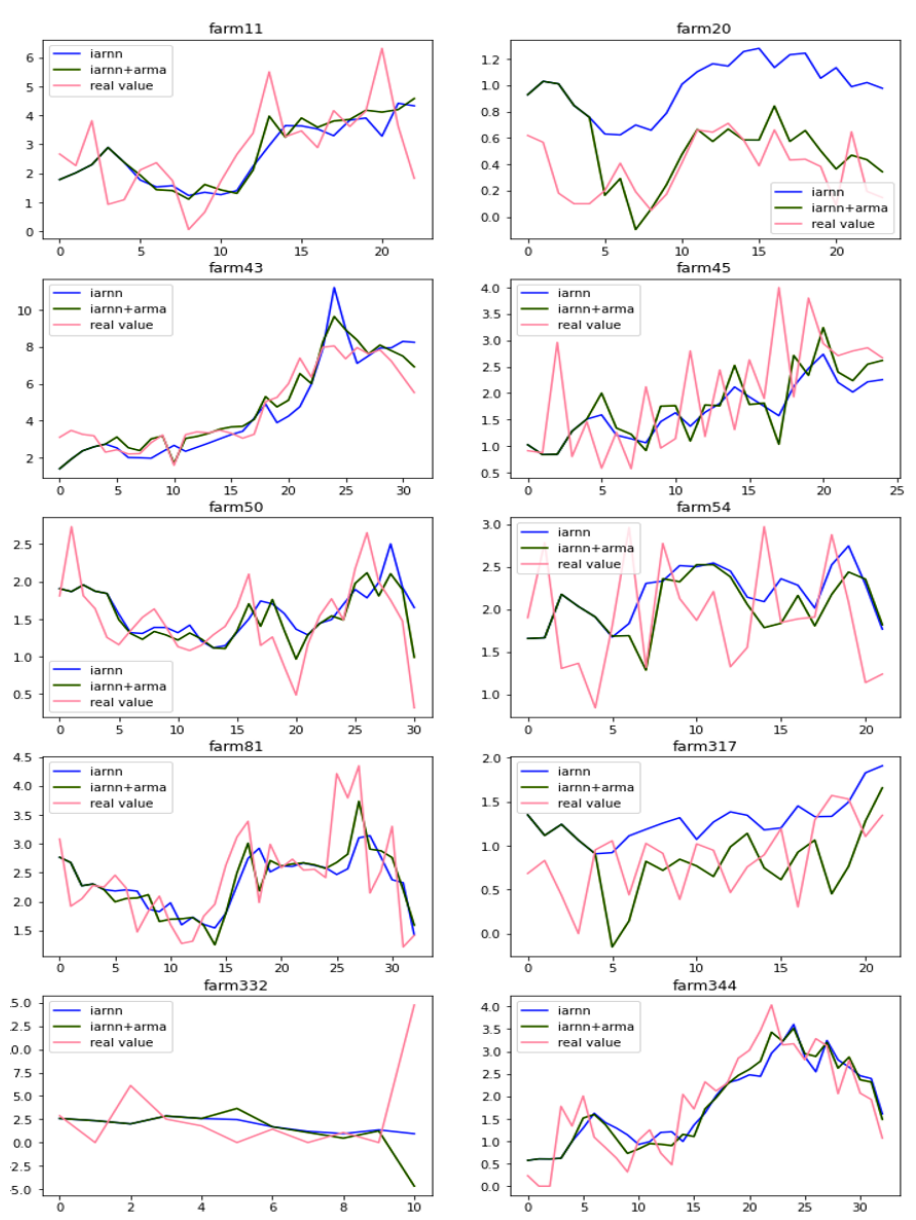
Figure 7. Comparison results of tomato yields prediction using input attention-based RNN and the proposed method.